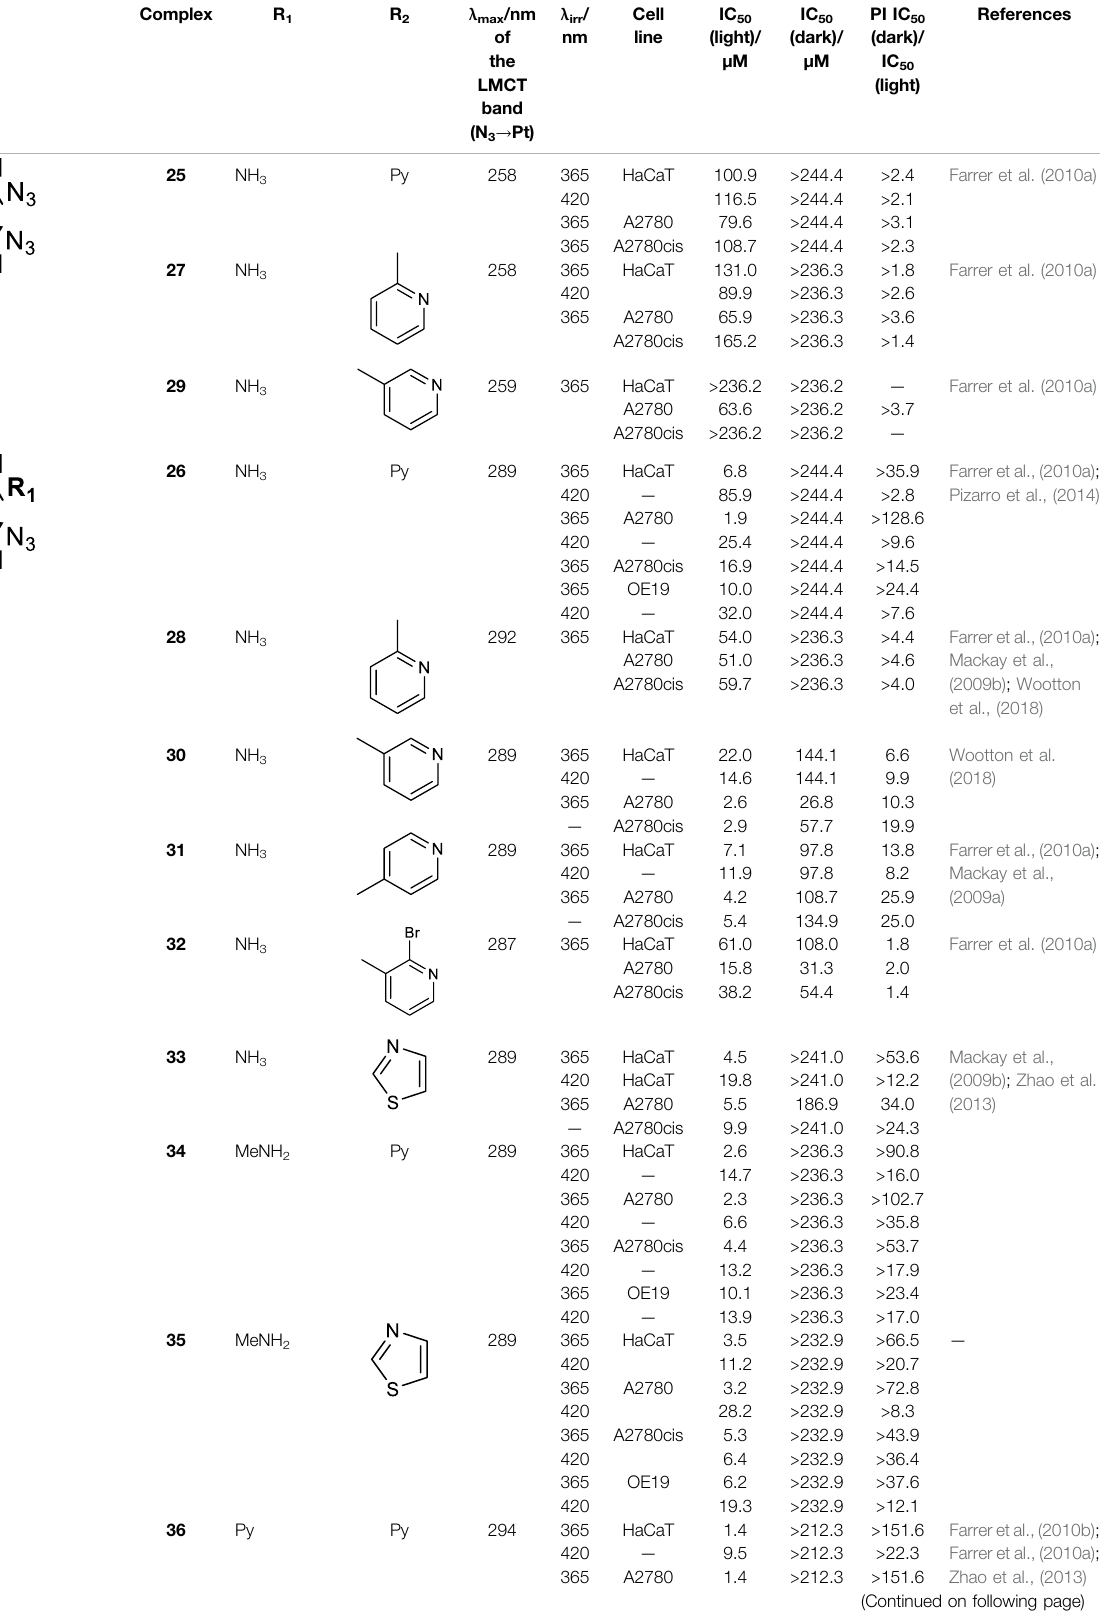
TABLE 5 | Chemical structures of complexes 25 – 43 and IC 50 values of complexes toward different cancer cell